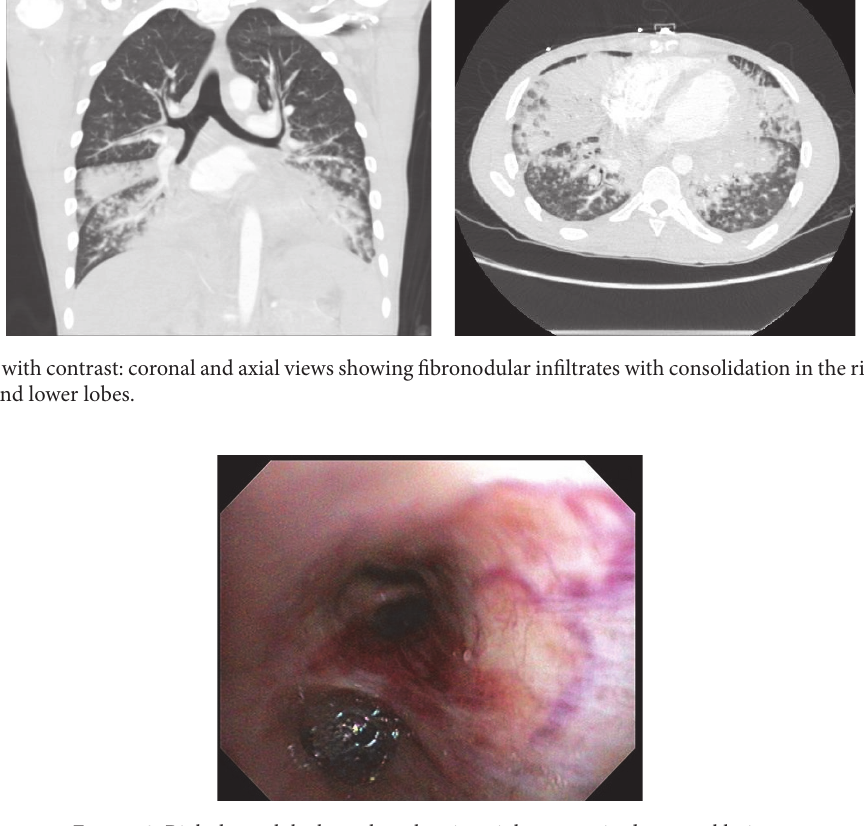
Figure 2: Right lower lobe bronchus showing violaceous raised mucosal